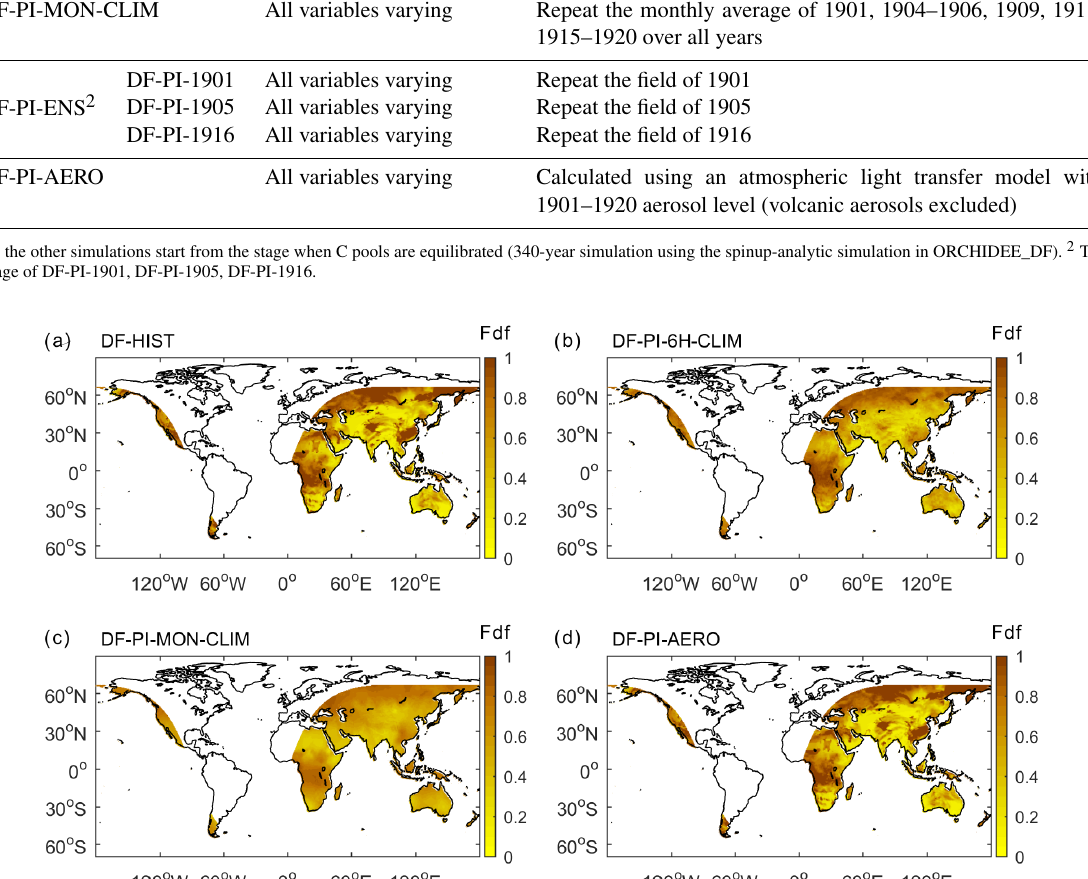
negative (cid:49) GPP, with magnitude larger than 40 gC m − 2 yr − 1 , over almost all vegetated